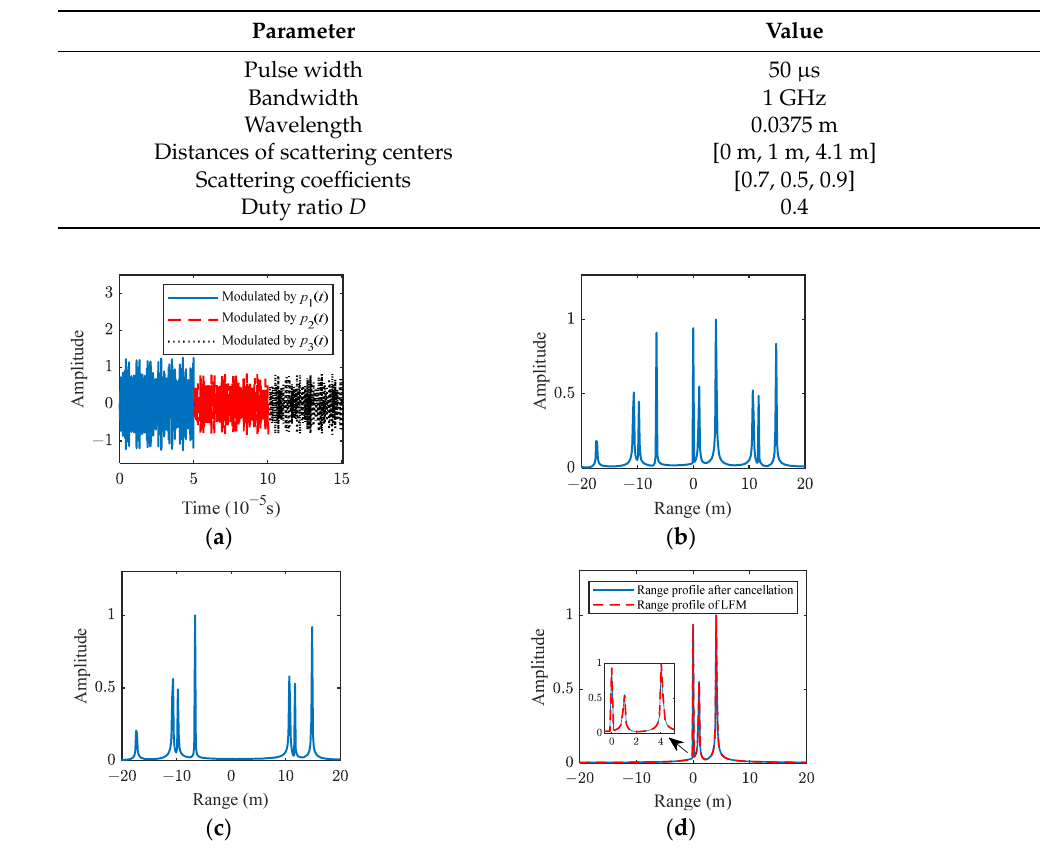
Figure 5. Range profile simulation results: ( a ) LFM signal echo after amplitude modulation; ( b ) Range profile of the first segment of the echo; ( c ) Range profile of the combined echo; ( d ) Range profile comparison.